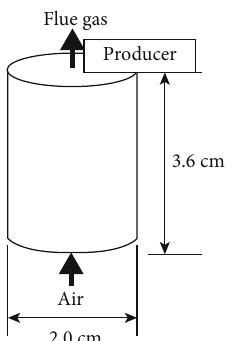
Figure 4: The numerical simulation model for kinetic cell (RTO) experiment.